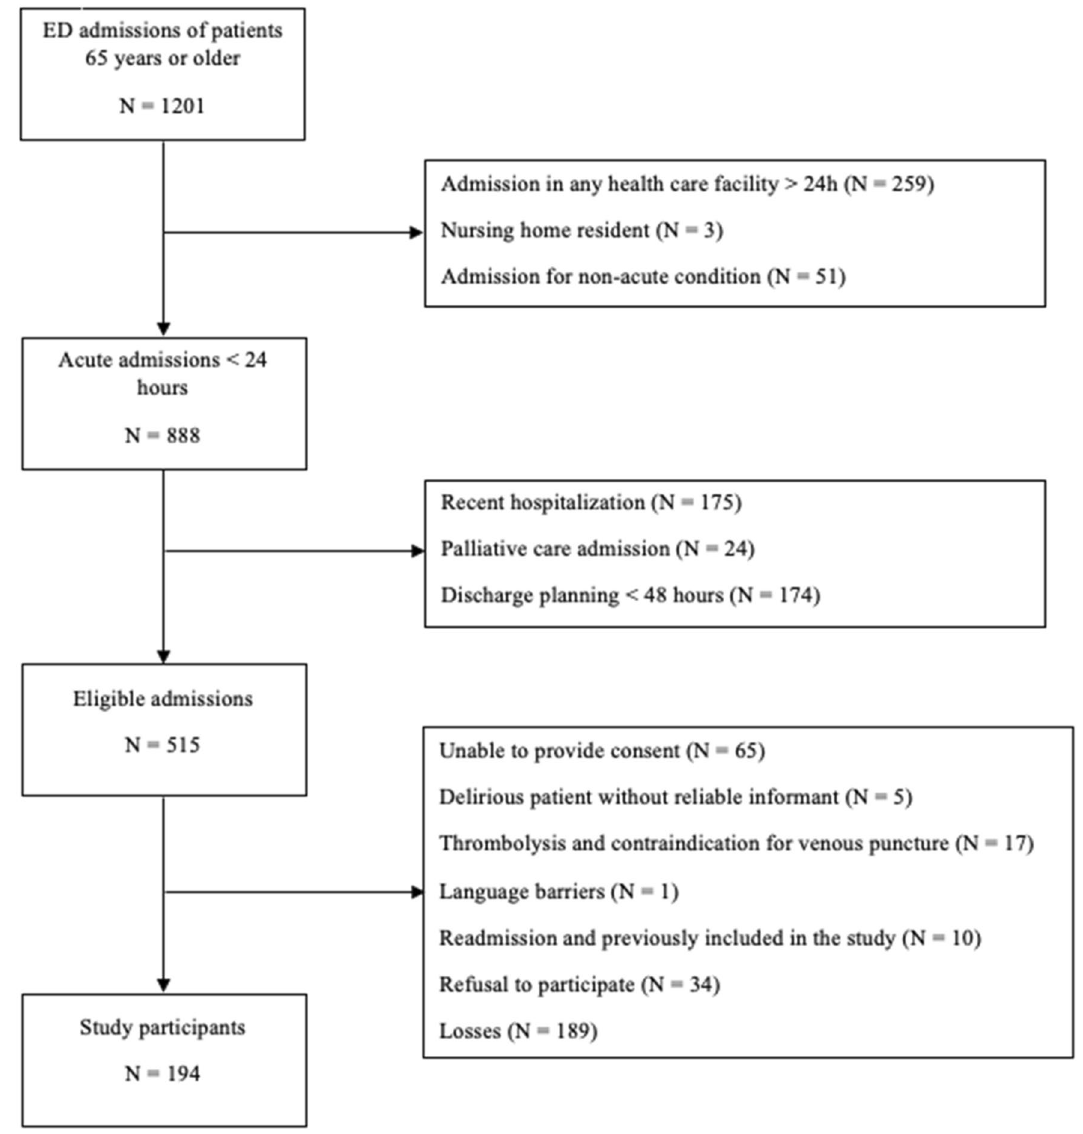
Figure 2. Flowchart illustrating the enrollment of the study